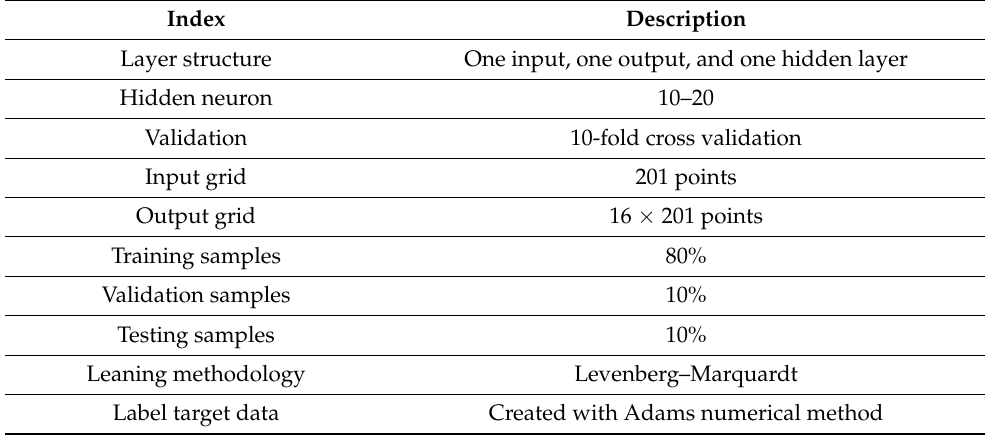
Table 1. Size and structural details of the networks.